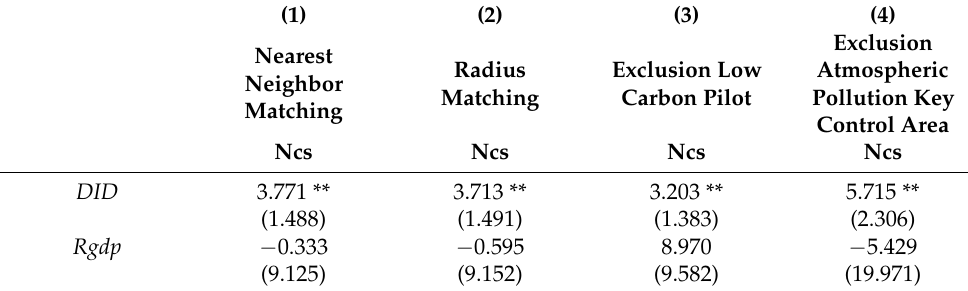
Table 4. Other robustness tests: PSM-DID and excluding the effects of other relevant policies in the same period.